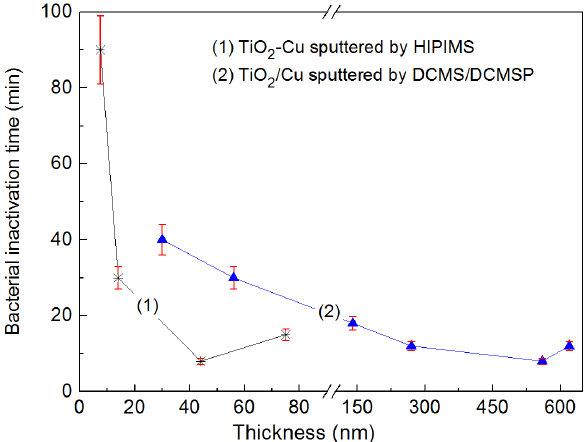
Figure 6. Bacterial inactivation time vs. nominal thicknesses for TiO 2 /Cu sputtered by High Power Impulse Magnetron Sputtering (HIPIMS) films and TiO 2 /Cu sputtered by Direct Current Magnetron Sputtering or Pulsed Direct Current Magnetron Sputtering (DCMS/DCMSP) irradiated under Osram Lumilux 18 W/827 actinic lamp (4 mW/cm 2 ). Error bars: standard deviation ( n = 10%).